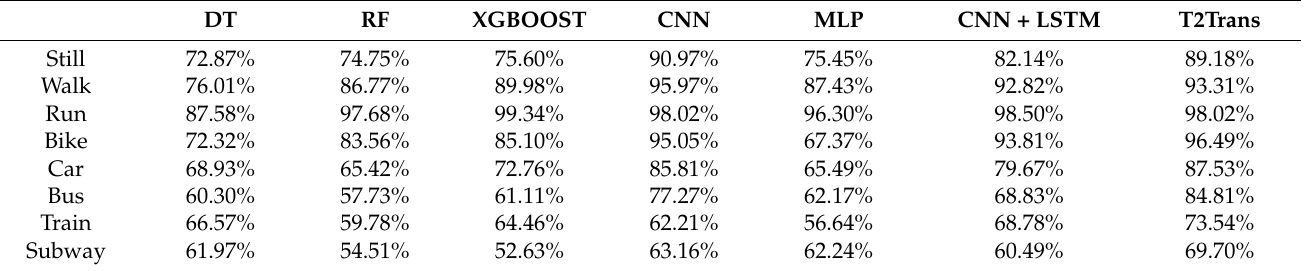
Table 3. The precisions of different transportation mode detection methods using different algorithms on the SHL dataset.